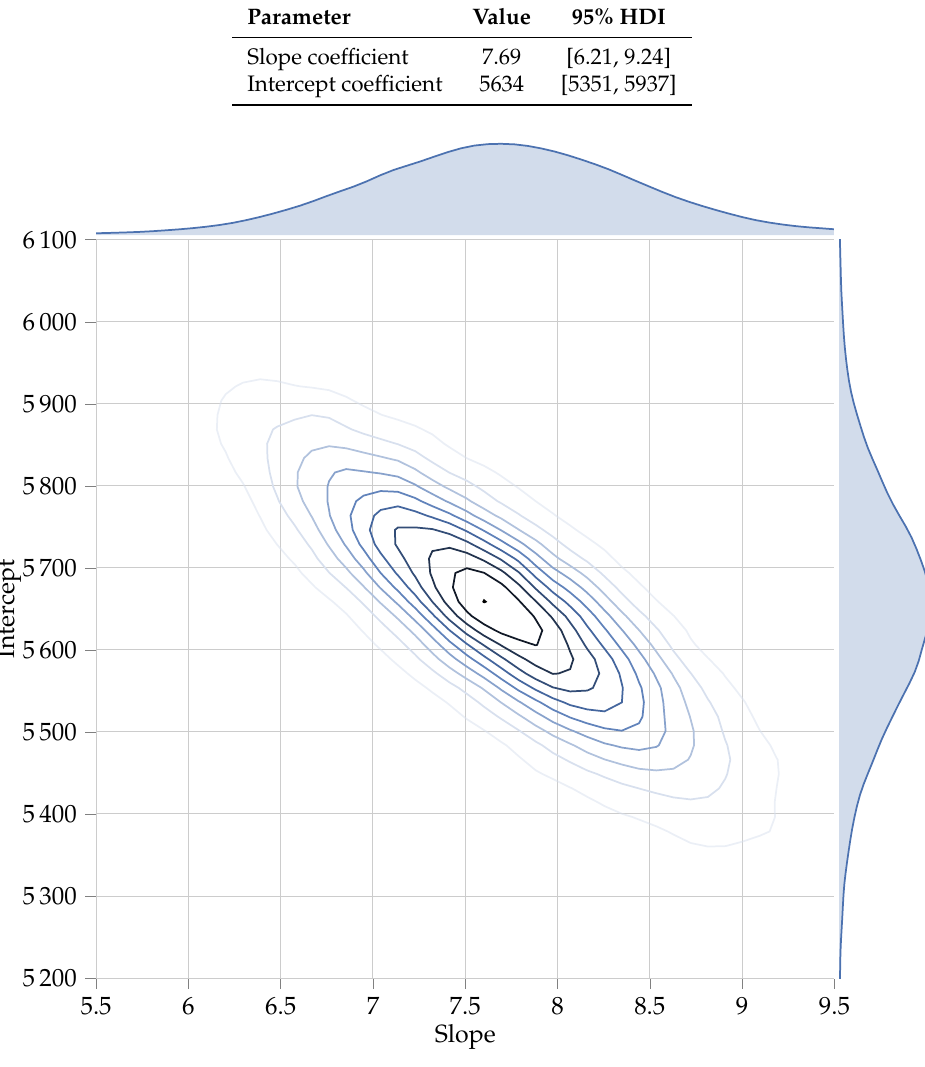
Figure 3. Joint plot of posterior distributions on the parameters of interest. The summary statistics are given in Table 3. Notice how the slope and intercept estimates are correlated: as the slope increases, the intercept decreases. The Markov Chain Monte Carlo (MCMC) algorithm explores this space, resulting in the real joint two-dimensional posterior distribution on the slope and